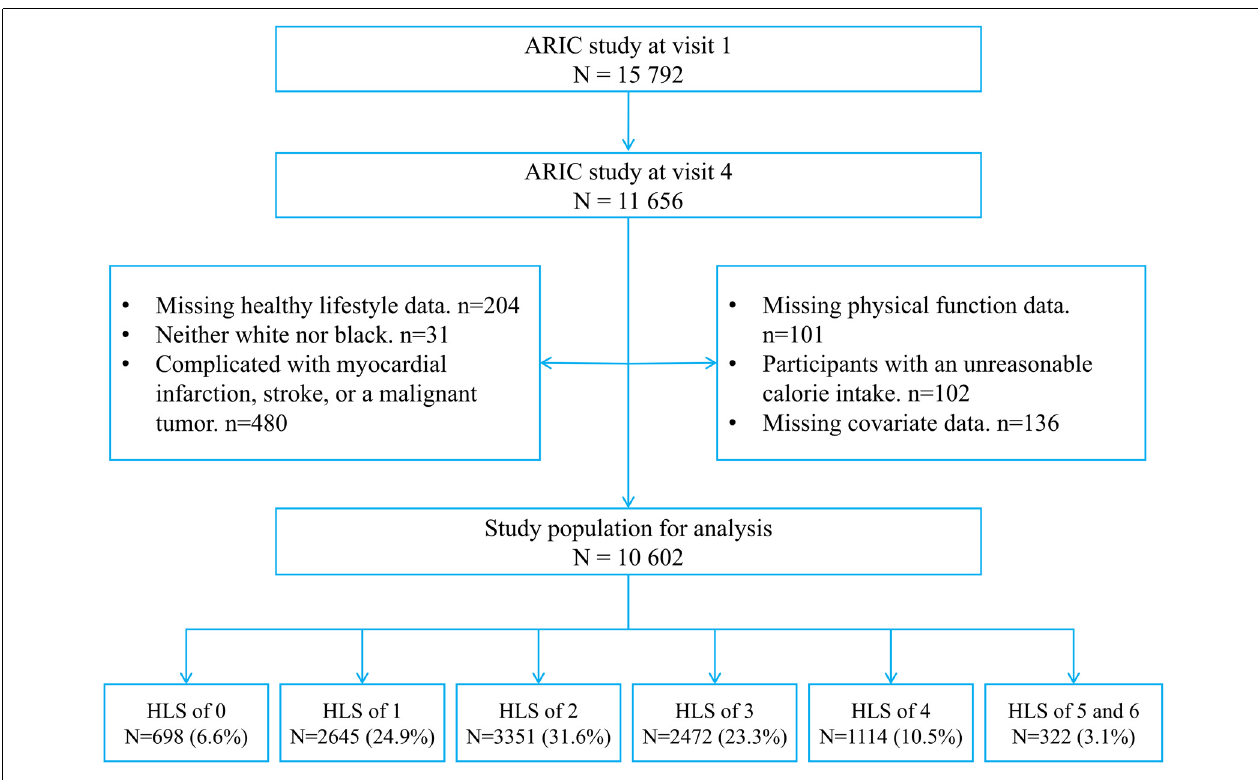
FIGURE 1 | Study flow chart. ARIC, Atherosclerosis Risk in